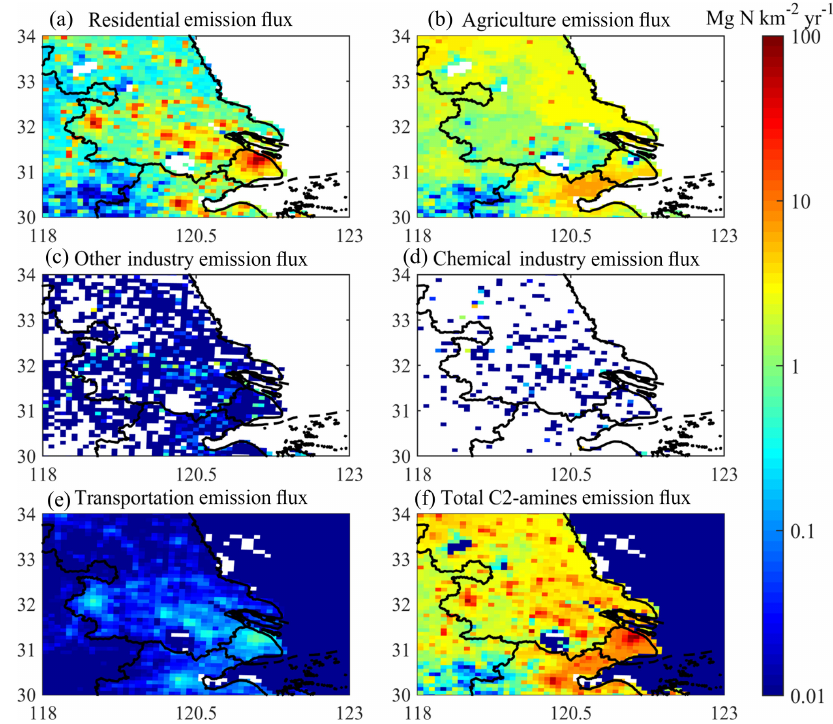
Figure 3. Same as Fig. 2 but for